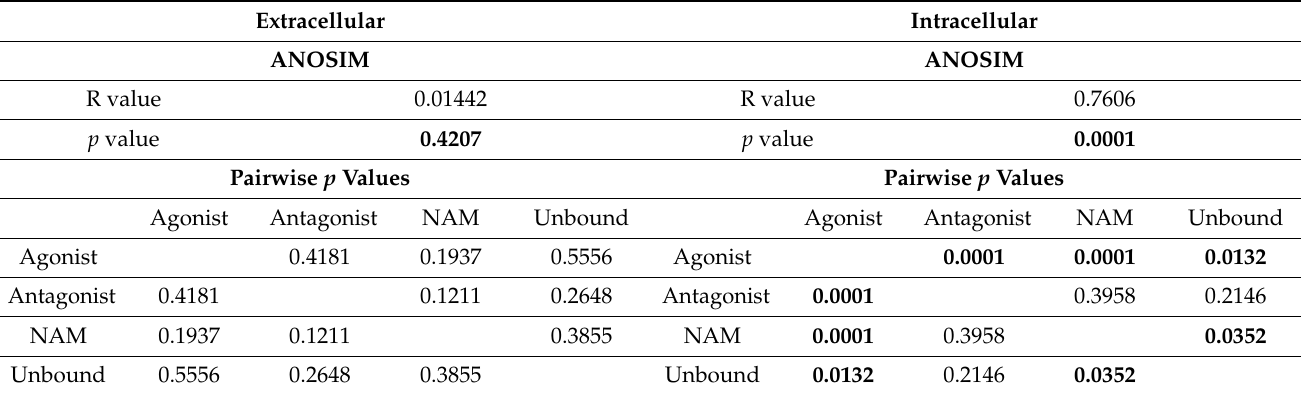
Table 4. A summary of ANOSIM (clustering) test data for the extra- and intracellular faces of the family B receptors, to support Figure 4. For statistical analysis, the partial agonist structure (5YQZ) was included in the agonist group; 9999 permutations performed on PC1-5, significant p values (<0.05) are shown in bold.